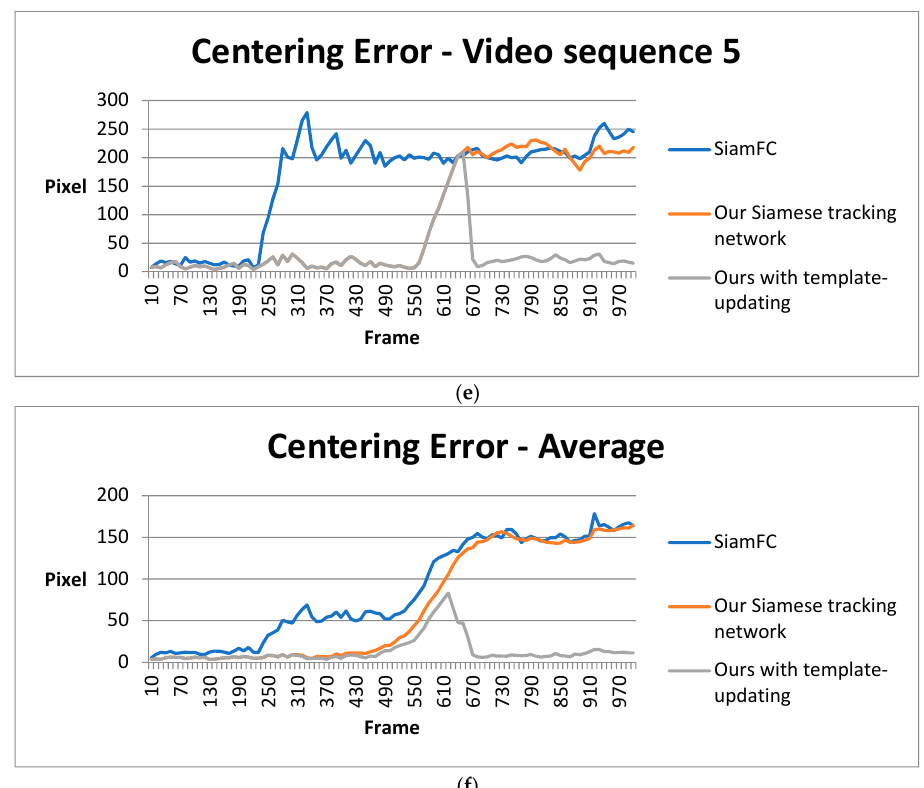
Figure 12. Statistical results of SiamFC, our Siamese tracking network, and our Siamese tracking network with template-updating strategy: ( a – e ) centering error of three methods in five different video sequences and ( f ) average centering error.